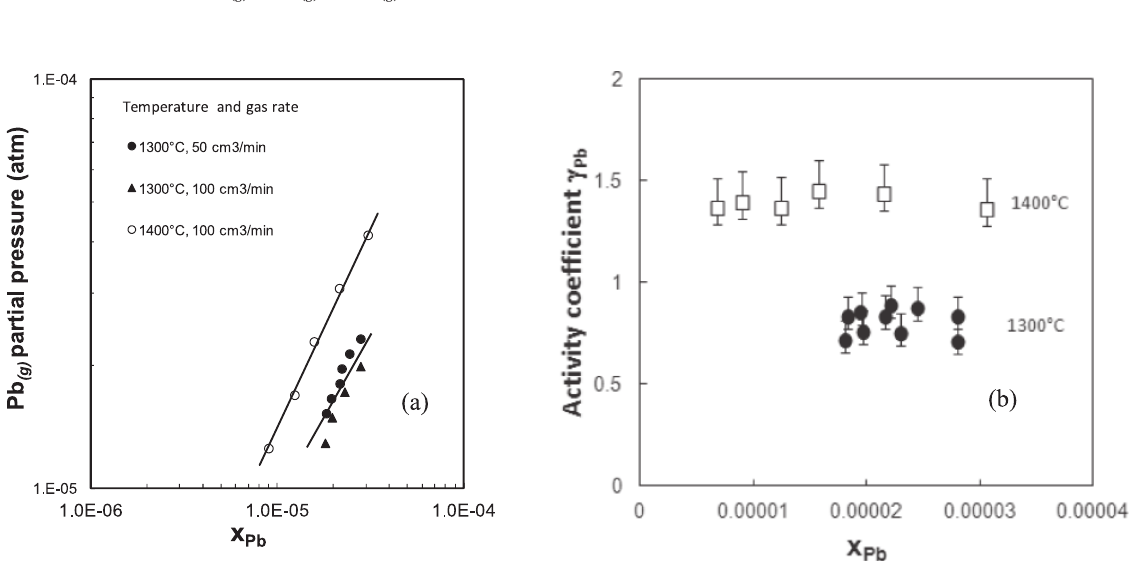
Fig. 7: a) Calculated partial pressure of Pb ( g ) from this study at 1300 and 1400 °C. b) Calculated activity coefficient of Pb with respect to Pb ( g ) from this study at 1300 and 1400 °C as a function of lead content in the matte.